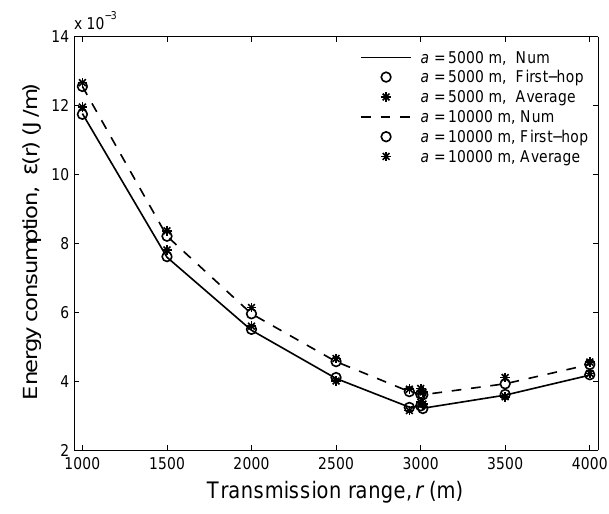
Figure 5. The optimal transmission range ( a ) and the corresponding energy consumption ( b ) under different node density